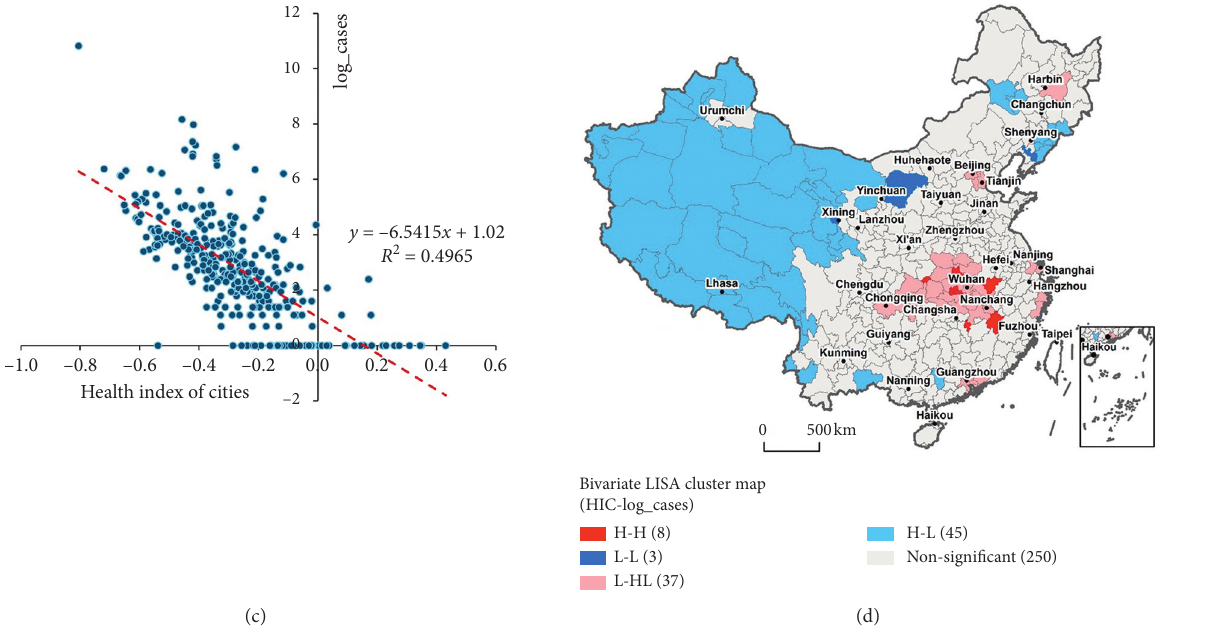
Figure 6: Spatial correlation between the HIC and the confirmed COVID-19 cases. (a) Mean HIC from January 20 to April 21, 2020. (b) Cumulative COVID-19 cases from January 20 to April 21, 2020. (c) Scatter plot between the HIC and log COVID-19 cases. (d) Bivariate Lisa cluster map of confirmed COVID-19 cases and the HIC.